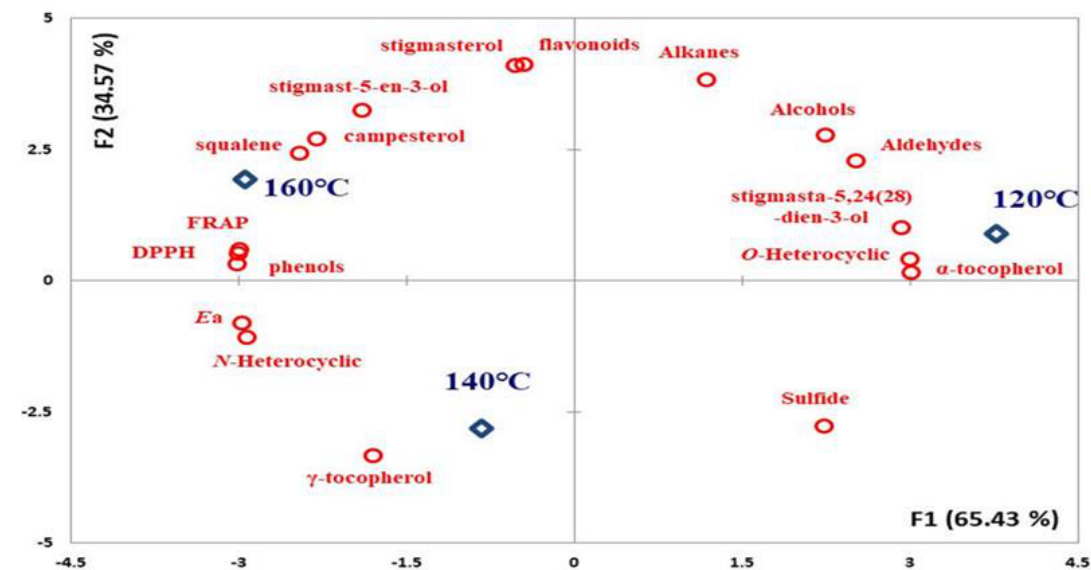
Figure 2. Principal component analysis (PCA) plots of composition change and oxidation stability for peanut oils generated by different roasting temperatures.